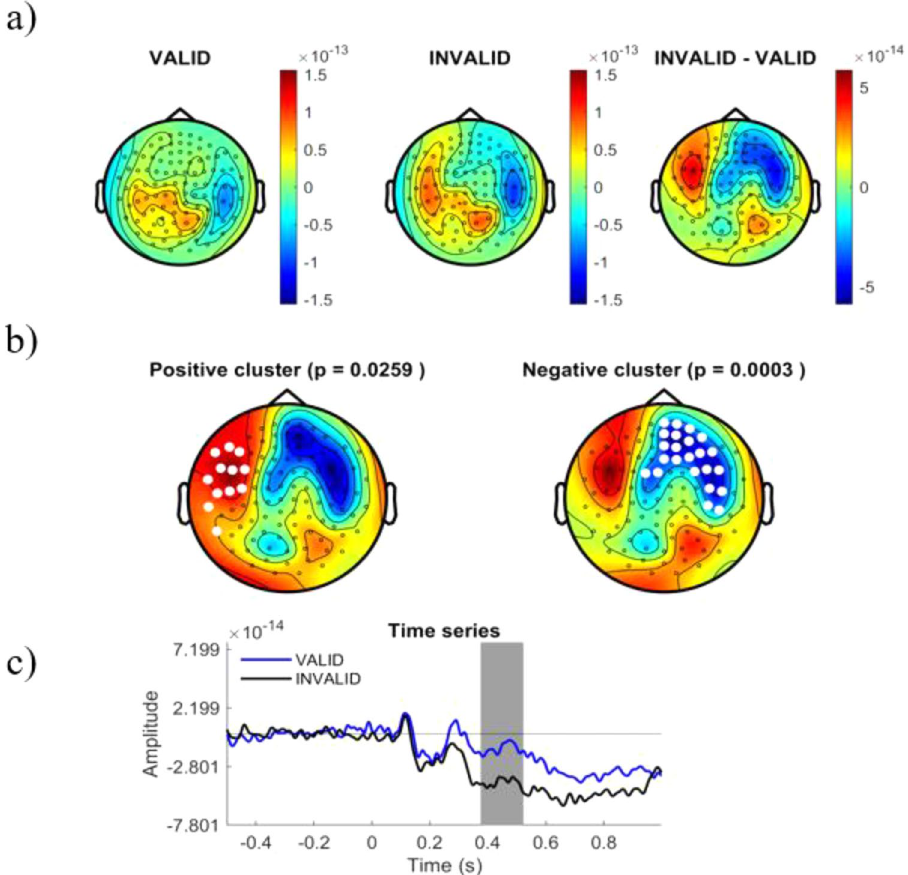
Figure 5. Represents the distribution of cortical activity in a time-slice from 375 to 525 ms. ( a ) Shows topographical maps of amplitudes for each condition (left and central map) and their arithmetic subtraction (right map). ( b ) Represents statistical differences (T values) between conditions. Left, positive cluster, and right, negative cluster. White dots represent sensors that showed significant differences during time-window. ( c ) Shows the whole time-series for both conditions (blue = VALID; black = INVALID). Grey mask represents time- slice of samples with significant